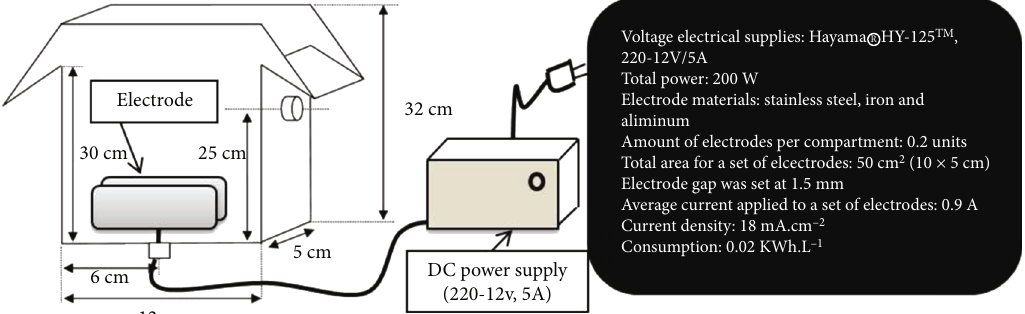
Figure 1: Electro fl otation-coagulation reactor in laboratory scale used in the experiments and WRD patterns of the